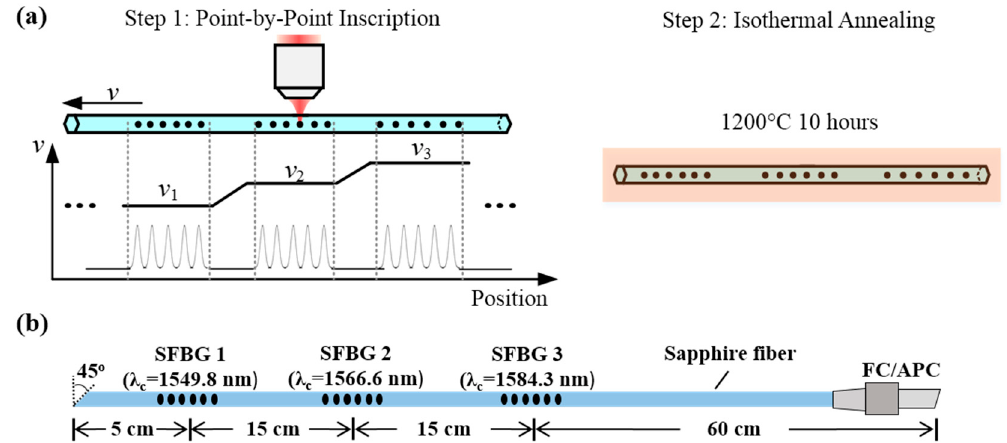
Figure 1. ( a ) Fabrication procedure for wavelength-multiplexed SFBGs via point-by-point method [15]. ( b ) Configuration of the fabricated sensing fiber. Note: SFBG = sapphire fiber Bragg